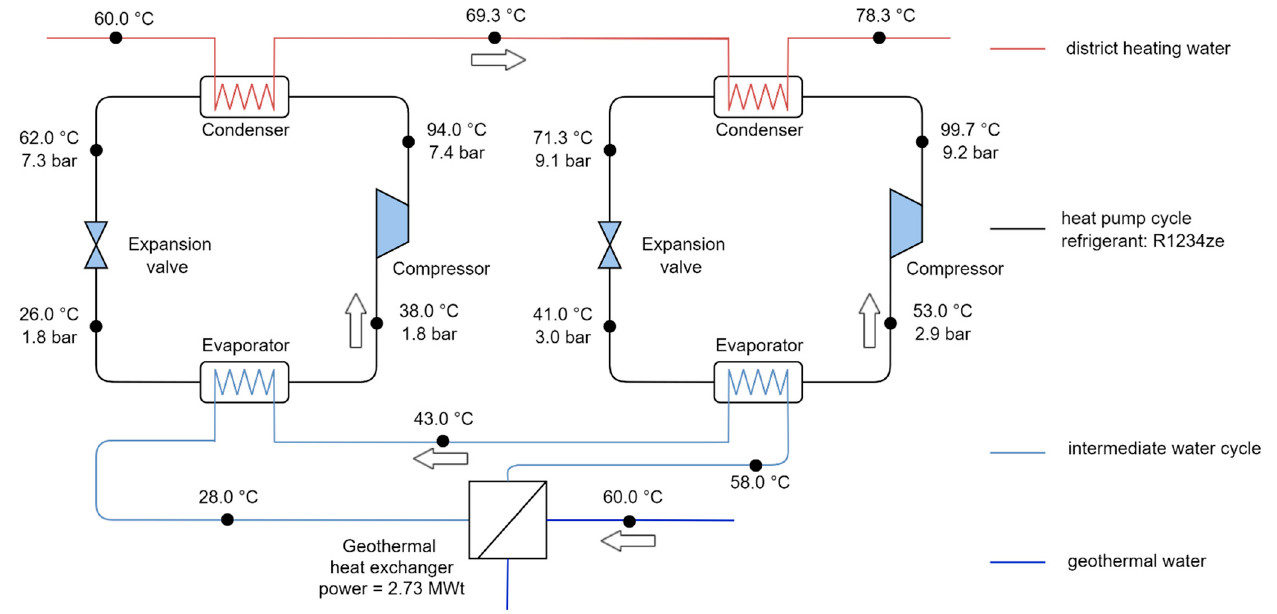
Figure 6. Scheme of the cascade variant.